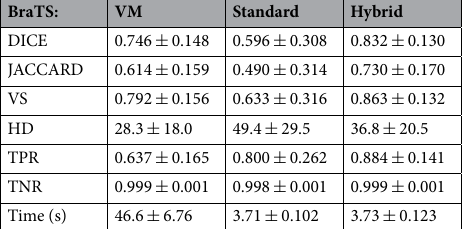
BraTS: VM Standard